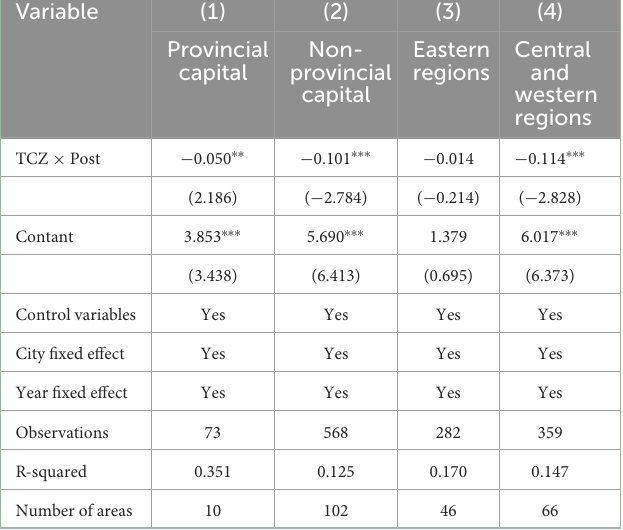
TABLE 5 Results of heterogeneity analysis.